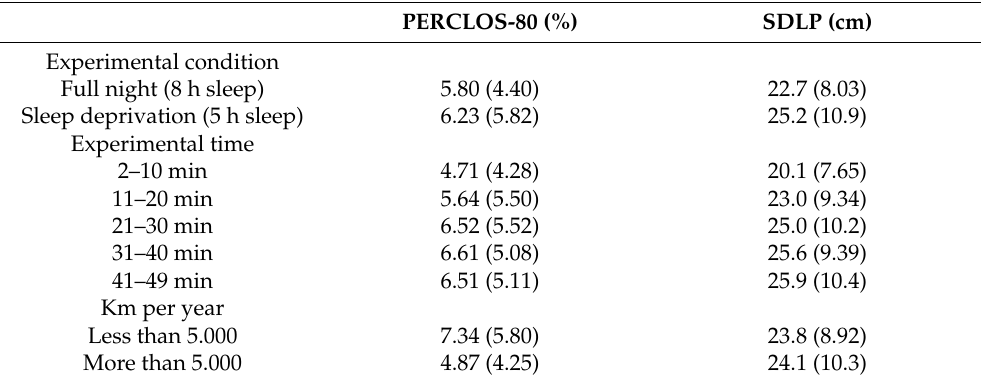
Figure 2. Smooth curves representing the percentage of eyelid closure below the 20% of the maximum openness (PERCLOS-80, top ) and the standard deviation from lateral position (SDLP, bottom ), divided by experimental condition (red: no sleep and 8 h sleep; blue: sleep deprivation and 5 h sleep). Table 1. Mean and standard deviation (between brackets) of the percentage of eyelid closure below the 20% of the maximum openness (PERCLOS-80) and the standard deviation from lateral position (SDLP), divided by: experimental condition (full sleep night with 8 h sleep, sleep deprivation with 5 h sleep), experimental time (five 10 min blocks) and kilometers travelled per year (more or less than 5.000).